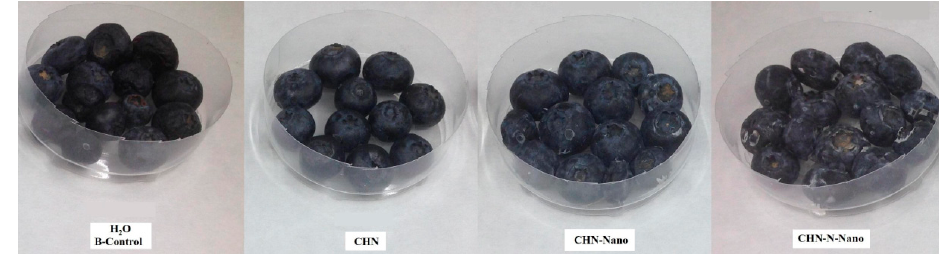
Figure 8. Optical evaluation of (uncoated and coated) blueberry fruits.